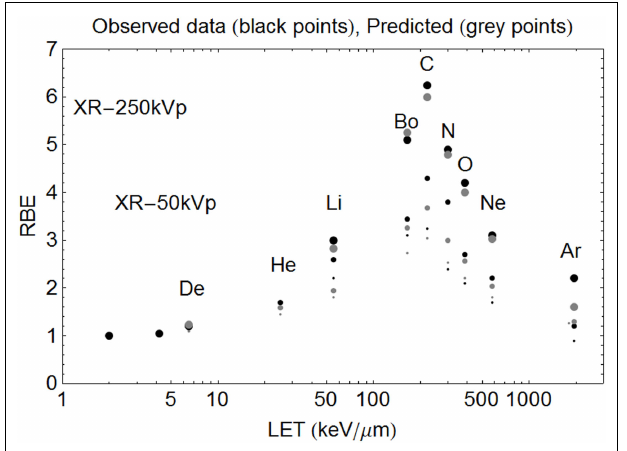
FIGURE 7 | Model predictions shown with data of Todd using the new Z -based model to determine LET U and ααα U , βββ U respectively, with LQ model correction for dose . The largest sized points are for SF = 50%, the intermediate sized points are for SF = 10%, and the smallest sized points are for SF = 1%. The ions used and their LET (keV/ μ m) values are given respectively in parentheses. Deuterium (6.5), Helium (25), Lithium (55), Boron (165), Carbon (220), Nitrogen (300), Oxygen (385), Neon (580), and Argon (1940). Observed RBE data are printed as black points, with estimated RBE values as gray points. Starting on the left hand side the first two black points are for 250 and 50kV X-rays respectively, followed by deuterons etc.